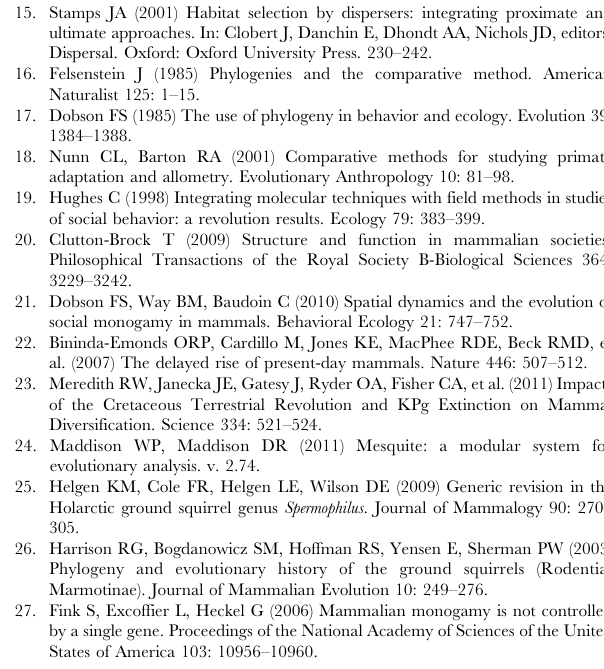
Table S1 Mating system and dispersal data for mammals. Table S2 Mating system and dispersal data for